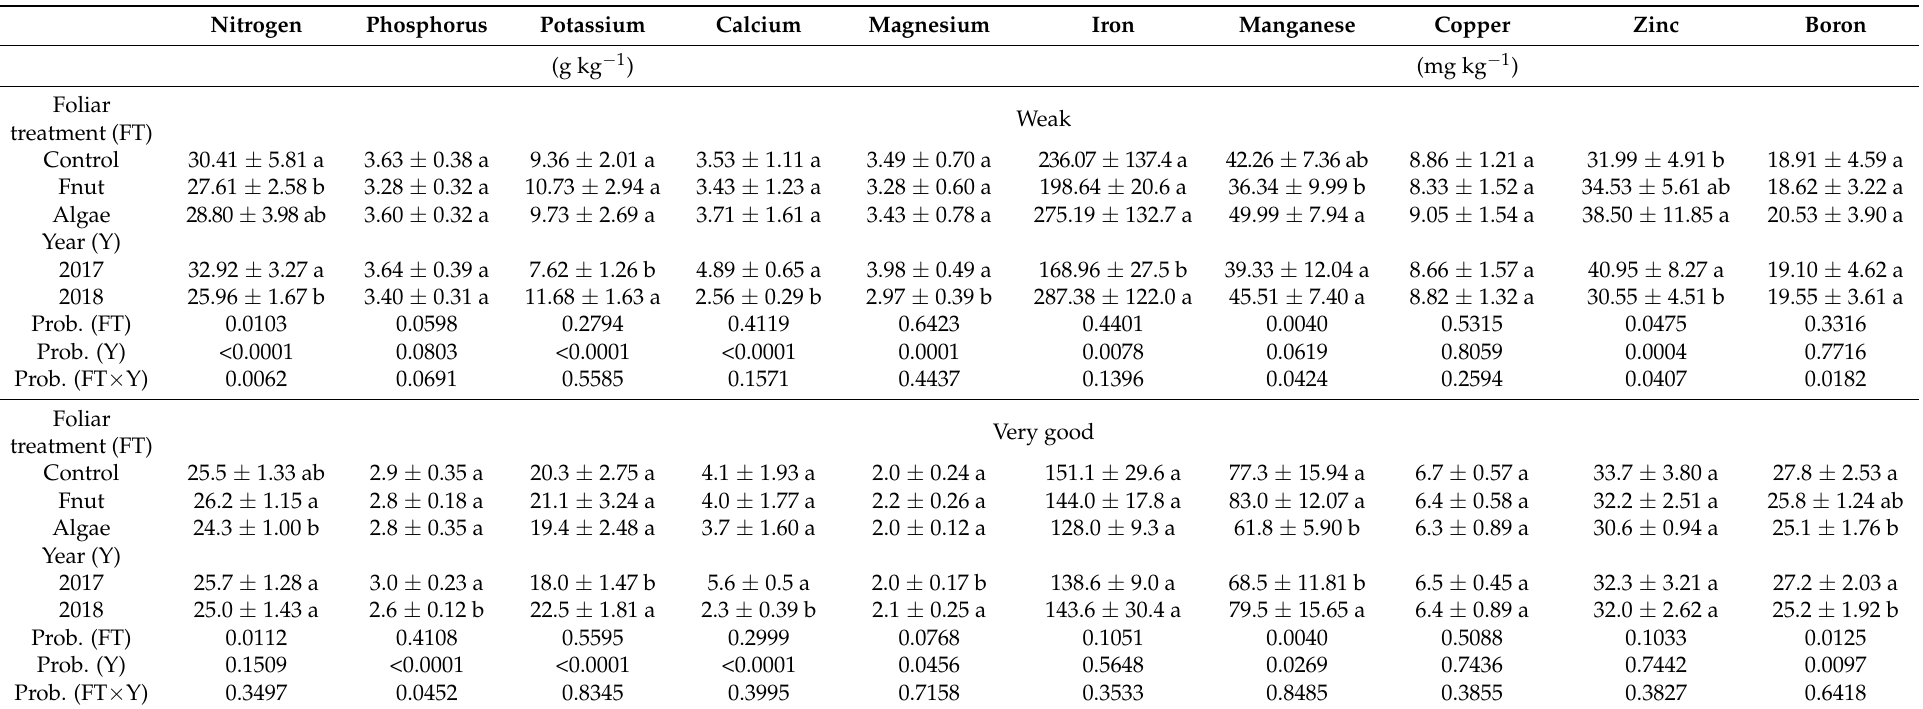
Table 3. Cone concentrations of macro and micronutrients (average ± standard error) in the plots of weak and very good vigour plants as a function of foliar treatment (Fnut, nutrient-rich foliar spray; Algae, algae-rich foliar spray; and Control), and year. Means followed by the same letter are not statistically different ( α = 0.05) by Tukey HSD tests (Foliar treatment) or Student’s t -tests